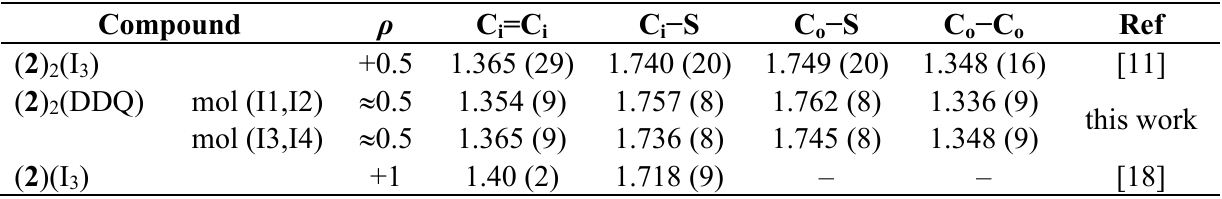
Table 3. Intramolecular bond lengths (in Å) in the TTF core of 2 (averaged values), depending on the actual charge ( ρ ). C TTF core.